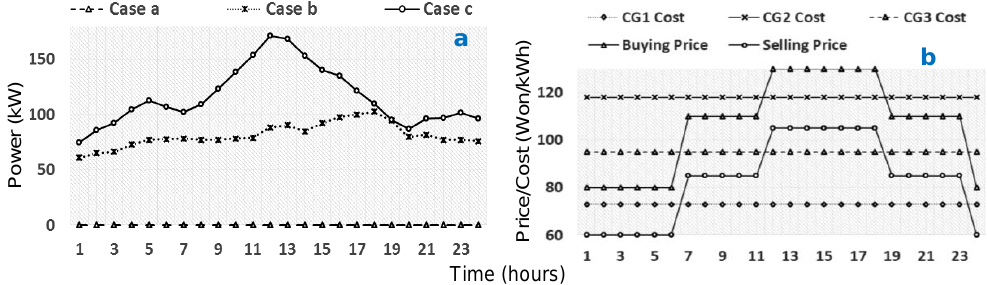
Figure 6. ( a ) Hourly collective uncertainty gap for both renewable power sources and electric loads; and ( b ) Market price signals along with generation cost of controllable distributed generators.